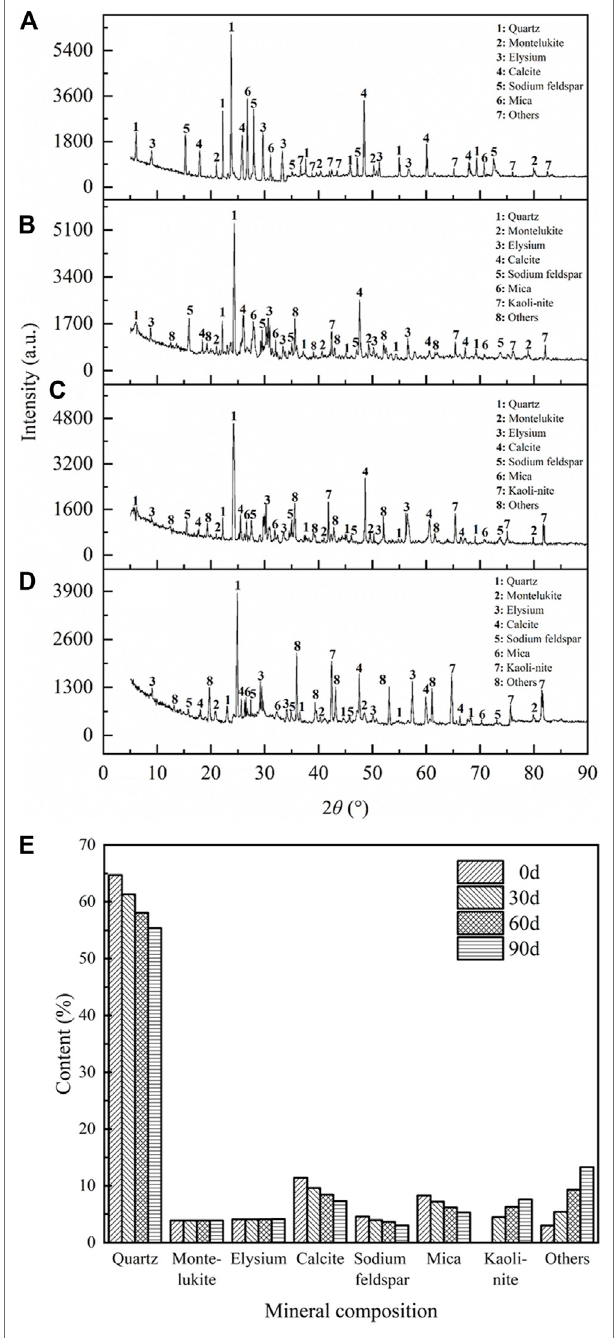
FIGURE 13 | X-diffraction patterns of sandstone specimens at various time nodes under high-humidity action: (A) 0 d; (B) 30 d; (C) 60 d; (D) 90 d; (E) the percentage of the main mineral content of the specimen at different time nodes of high-humidity.